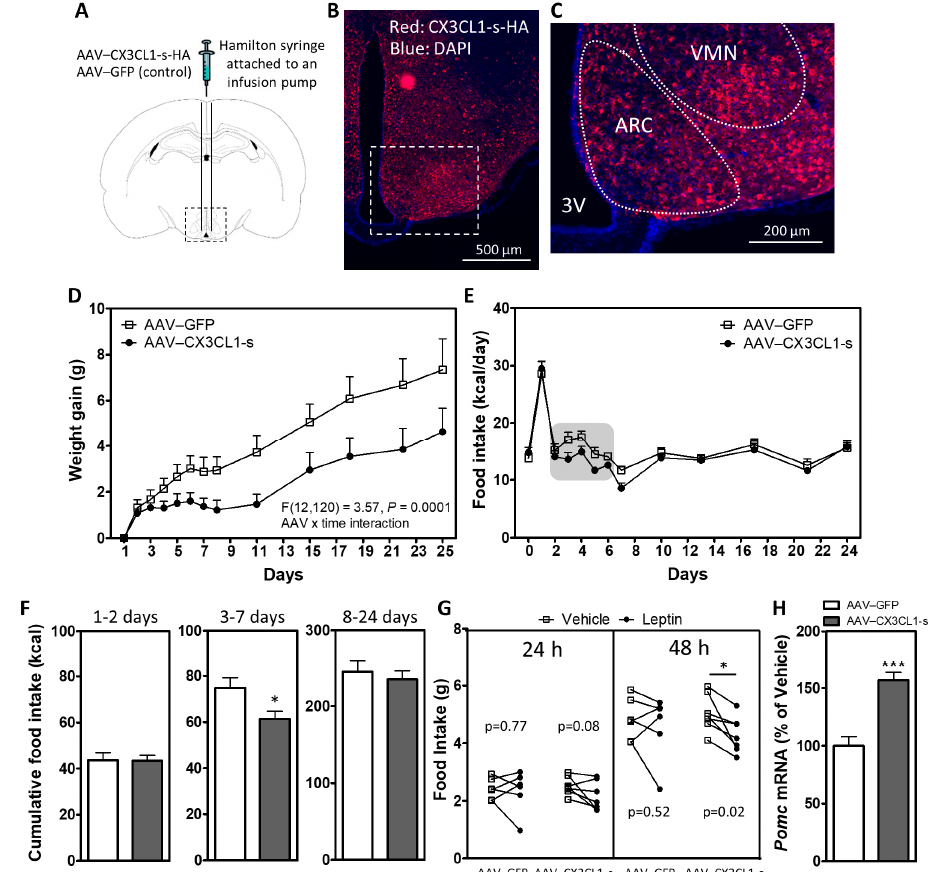
Figure 1. Hypothalamic overexpression of soluble CX3CL1 reduces weight gain, food intake and improves leptin sensitivity in DIO mice. ( A ) Schematic diagram of a mouse coronal brain section indicating bilateral administration of AAVs into the mediobasal hypothalamus. ( B , C ) Representative image of a hypothalamic section from a mouse treated with AAV–CX3CL1-s. CX3CL1-s overexpression in the MBH is indicated by HA staining (red). Higher magnification view in C shows broad expression in the arcuate nucleus (ARC) and ventromedial hypothalamus (VMH). ( D , E ) Body weight gain ( D ) and 24 h food intake ( E ) in HFD-fed mice with hypothalamic overexpression of GFP (AAV–GFP) or the soluble isoform of CX3CL1 (AAV–CX3CL1-s) measured daily over the first week and then bi-weekly until day 25 of HFD. ( F ) Cumulative food intake over days 1–2 (left panel), 3–7 (middle panel) and 8–24 (right panel). ( G ) 24 h and 48 h food intake after i.p. saline or leptin injections (2 µ g/g/day) in AAV–GFP and AAV–CX3CL1-s mice on HFD. Data are presented as mean ± SEM of at least 6 animals per group. ( H ) Hypothalamic mRNA expression of Pomc in chow-fed